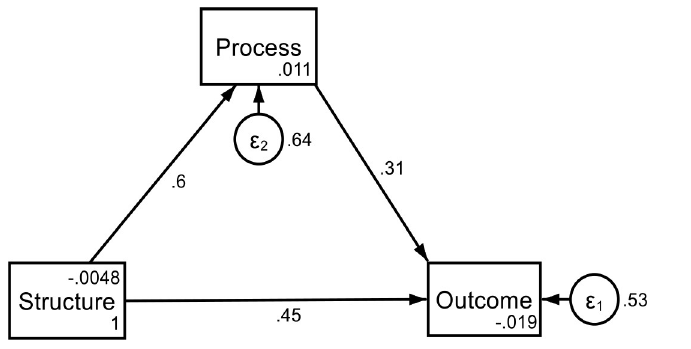
Fig 3. Pathway analysis diagram of the mediation effect.